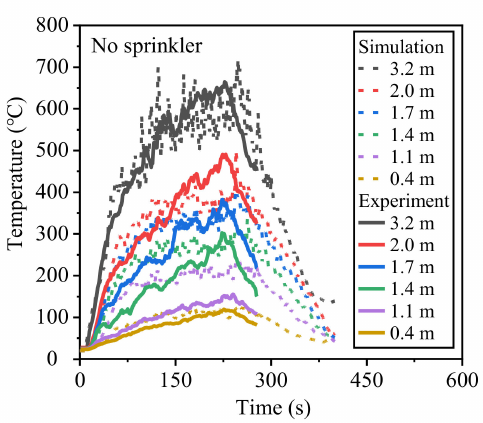
Figure 7. Comparison of window edge temperatures between the simulation and experiment under the non-sprinkler